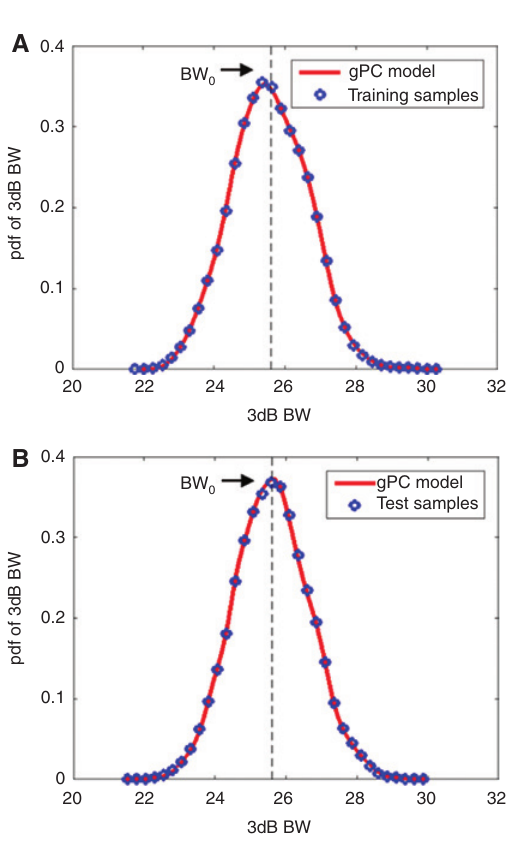
Figure 3: 3 dB bandwidth pdfs of the combined gPC model with (A) Monte Carlo training samples and (B) Monte Carlo test samples.